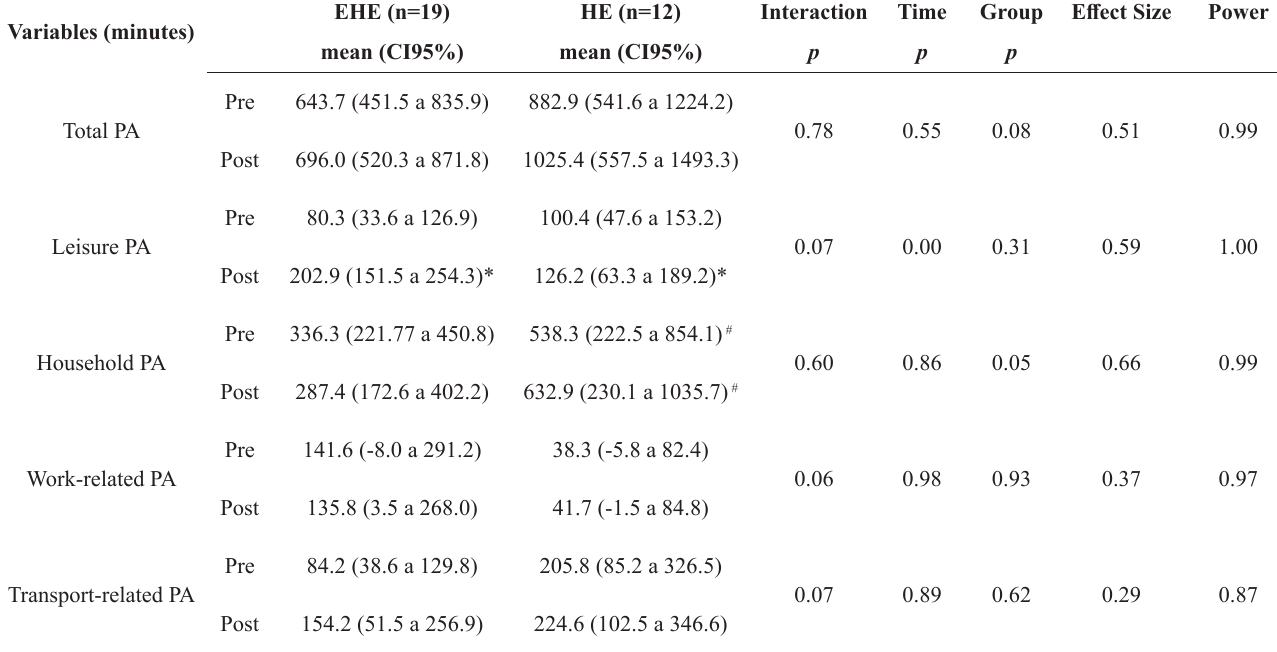
Table 2 - Mean and Confidence Interval (CI 95%) of pre- and post-intervention values of physical activity measured through the IPAQ ques - tionnaire separated by intervention